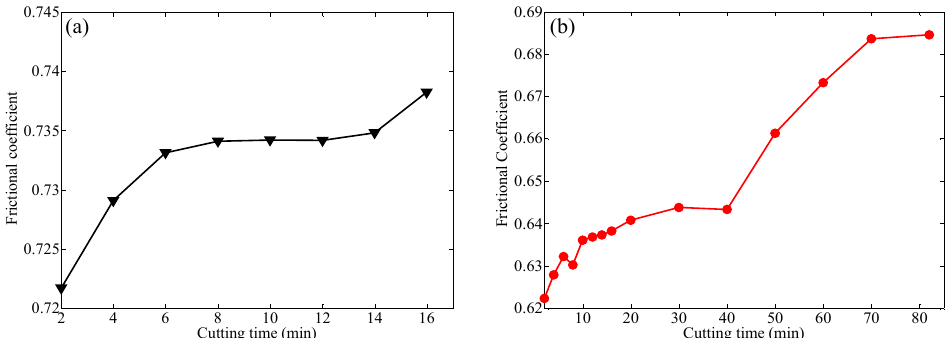
Figure 10. ( a ) Changes in Tool A frictional coefficient with time. ( b ) Changes in Tool B frictional coefficient with time.